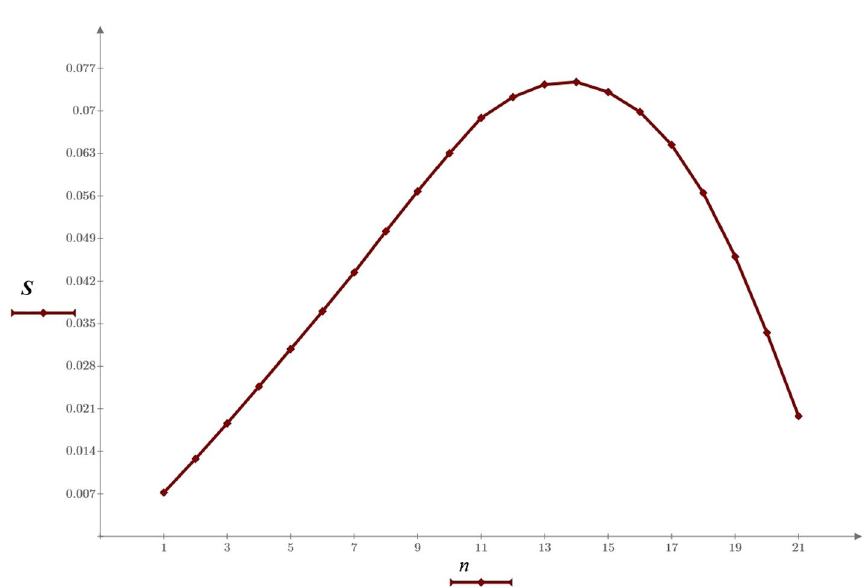
Fig. 4 Antenna coupling